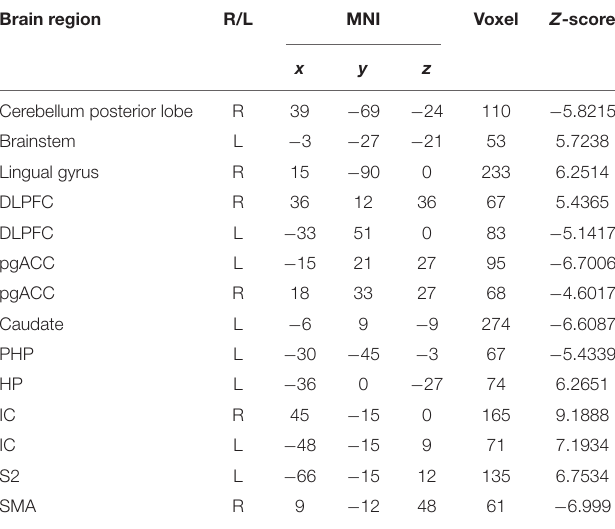
TABLE 3 | Summary of the brain areas indicating functional connectivity with the rACC in placebo response in female participants ( p < 0.05, FDR < 0.05). Brain region